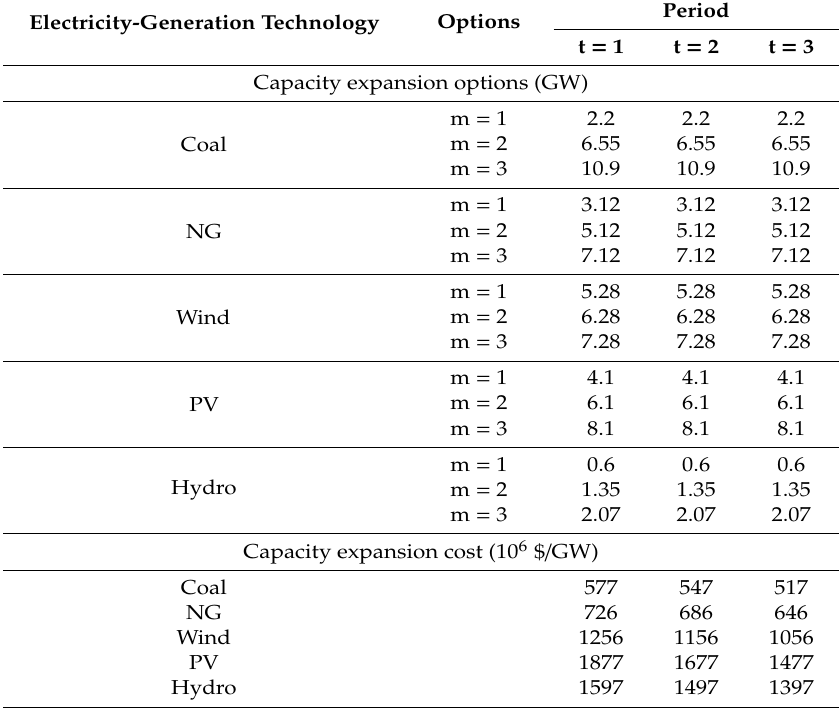
Table 3. Expansion options and expansion costs for electricity generation